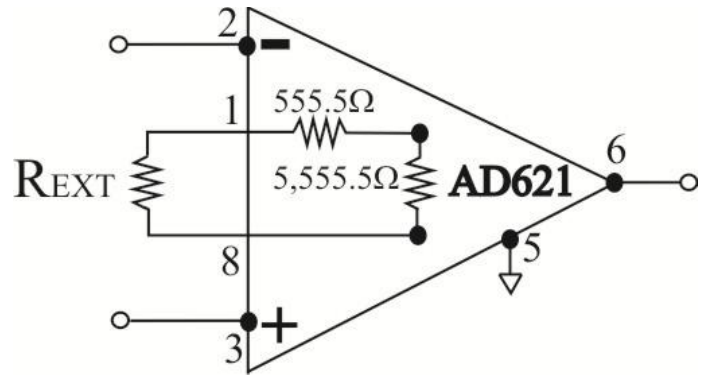
Figure 4. Amplitude-frequency characteristic of the